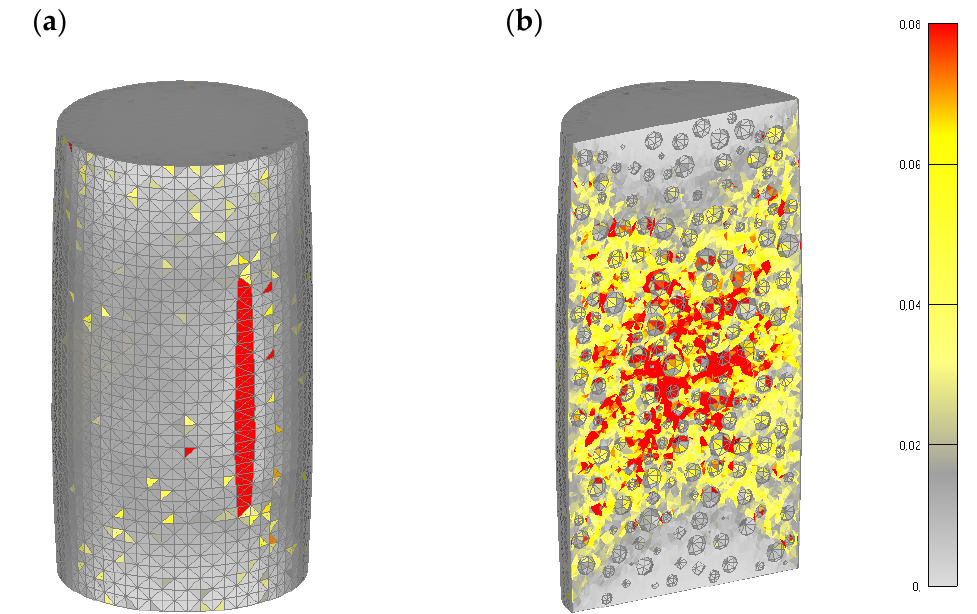
Figure 14. Typical failure mode R 75: ( a ) concrete damage and ( b ) internal distribution of damage in mortar (maximum principal strains).